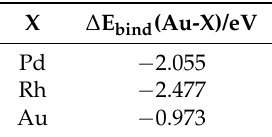
Table 2. Binding energies between a gold slab and its second layer, where the second layer can be Pd, Rh, or Au. The former systems correspond to a complete underlayer of Pd or Rh metals on the Au(111) surface and the latter system corresponds to the pure gold